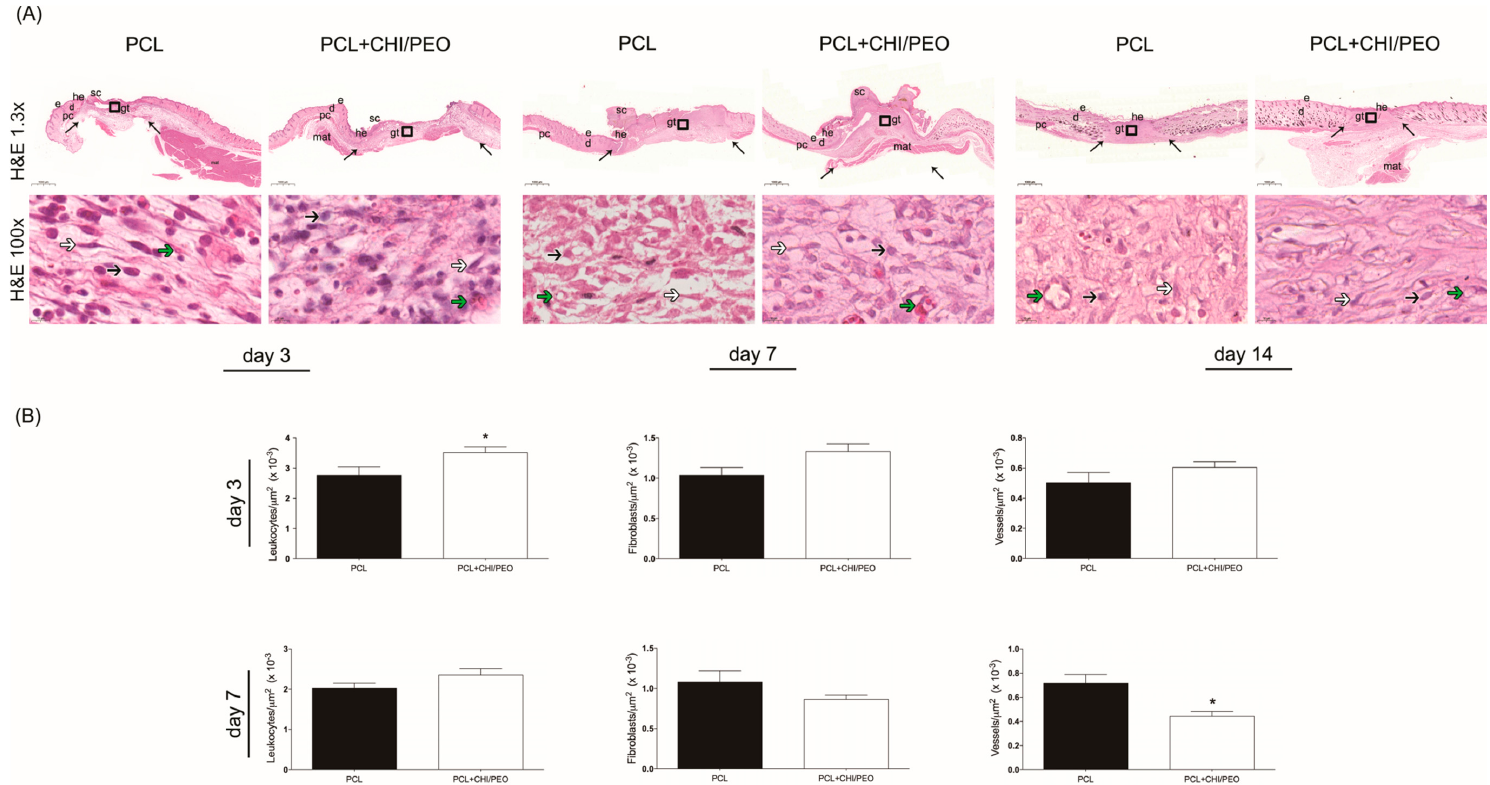
Figure 3. ( A ) Histological analysis of the injured region of the PCL and PCL + CHI / PEO groups on the 3rd, 7th, and 14th day after lesion with Hematoxylin and Eosin stain. The arrows in the upper panels indicate the limits of granulation tissue area and small letters represent: d, dermis; e, epidermis; g, granulation tissue; he, hypertrophic epidermis; sc, scab; pc, panniculus carnosus and mat, multilocular adipose tissue. Boxes in the upper panels indicate the area where the regions are shown in higher magnification to illustrate leucocytes (black arrows), fibroblasts (white arrows) and microvessels (green arrows). Objective: 1.3× (upper panels) and 100× (lower panels). ( B ) Graphical representation of the number of inflammatory infiltrates, blood vessels, and fibroblasts in the region of excisional lesions treated topically with PCL and polycaprolactone coated with chitosan and poly(ethylene oxide) (PCL + CHI / PEO) membranes on the 3rd and 7th day after lesion. The results were expressed as mean ± standard deviation. * p < 0.05 indicates statistically significant differences between treatments according to the Student’s t test.